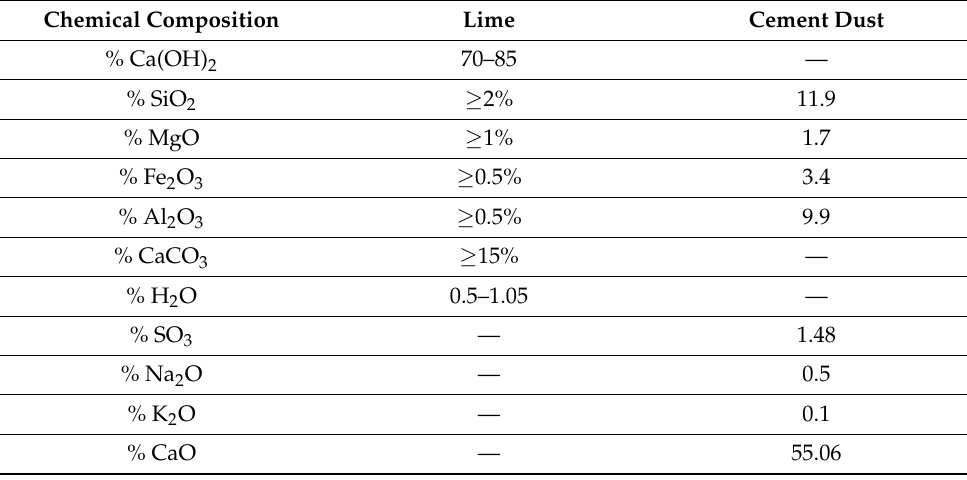
Table 2. Specifications of lime and cement kiln dust.